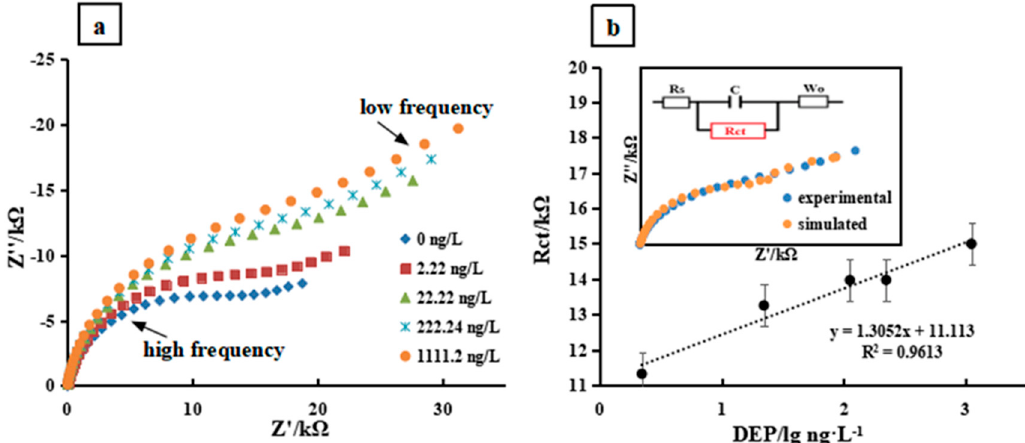
Figure 3. ( a ) Impedance spectrum of PAEs concentration gradient. The concentration of DEP was 0, 2.22, 22.22, 222.24, and 1111.2 ng/L, respectively. The measured solution contained 0.5 M NaCl and 0.01 M K 3 [Fe(CN) 6 ]. EIS was measured under an open circuit voltage with an AC amplitude of 10 mV and a frequency range of 1 Hz–0.1 MHz. Each concentration was measured three times, and its mean value was plotted; ( b ) The R ct values with respect to corresponding DEP concentrations. The inset shows a representative simulated Nyquist curve superposed with the experimental measurements according to corresponding equivalent circuits.